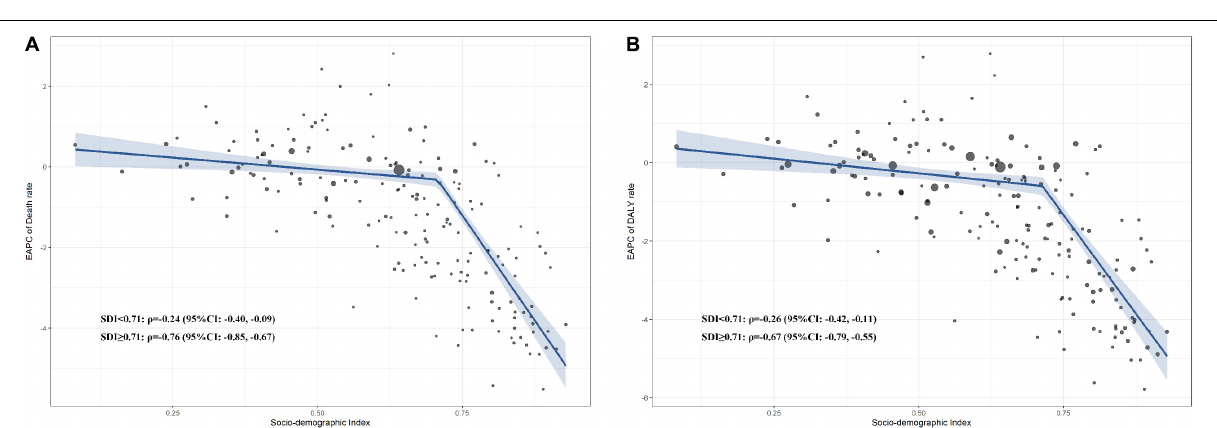
FIGURE 1 | The ASR of high LDL-C attributable death and DALY in 2019, and the EAPC of age-standardized death and DALY rate from 1990 to 2019 in 204 countries and territories. (A) ASR of high LDL-C attributable SEV in 2019; (B) ASR of high LDL-C attributable death in 2019; (C) ASR of high LDL-C attributable to DALY in 2019; (D) EAPC of age-standardized SEV rate from 1990 to 2019. (E) EAPC of age-standardized death rate from 1990 to 2019; (F) EAPC of age-standardized DALY rate from 1990 to 2019. DALY, disability-adjusted life year; SDI, social-demographic index; EAPC, estimated annual percentage change; SEV, summary exposure value; ASR, age-standardized rate; LDL-C, low-density lipoprotein-cholesterol.